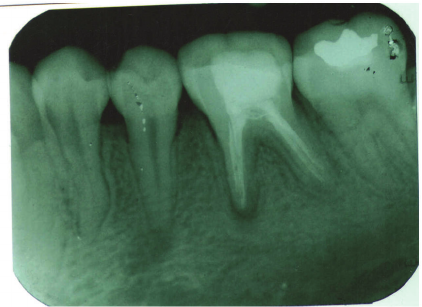
Figure 4: Obturation (36).